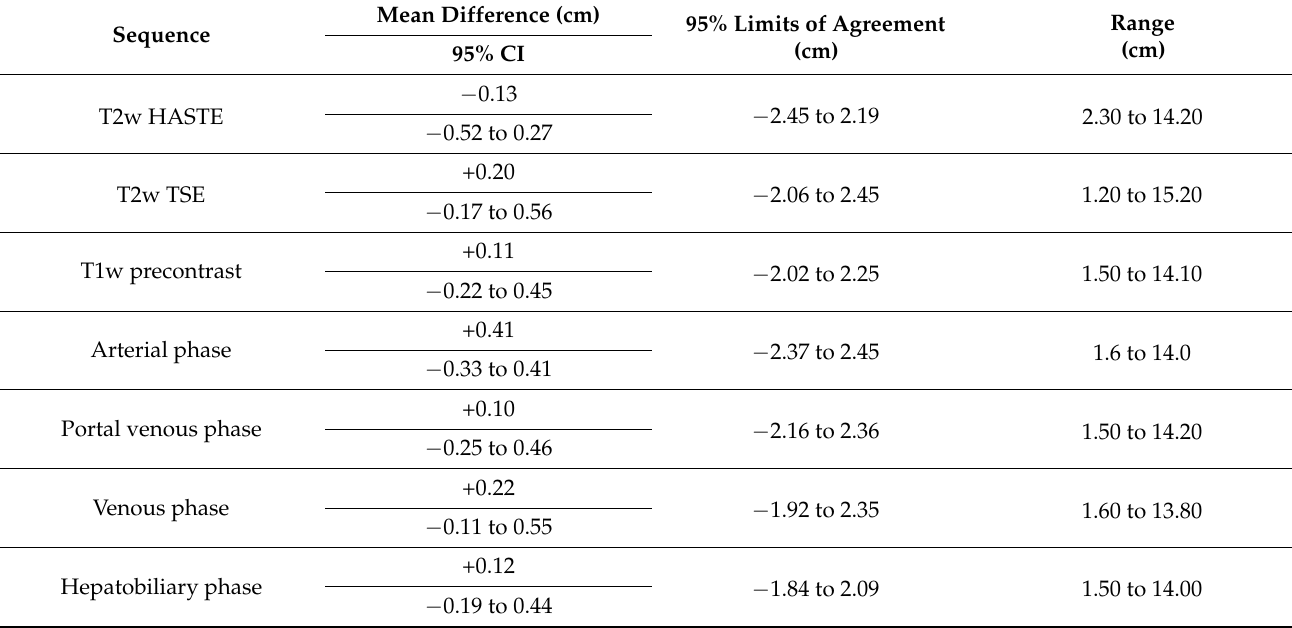
Table 6. Bland–Altman assessment of different MRI sequences vs.